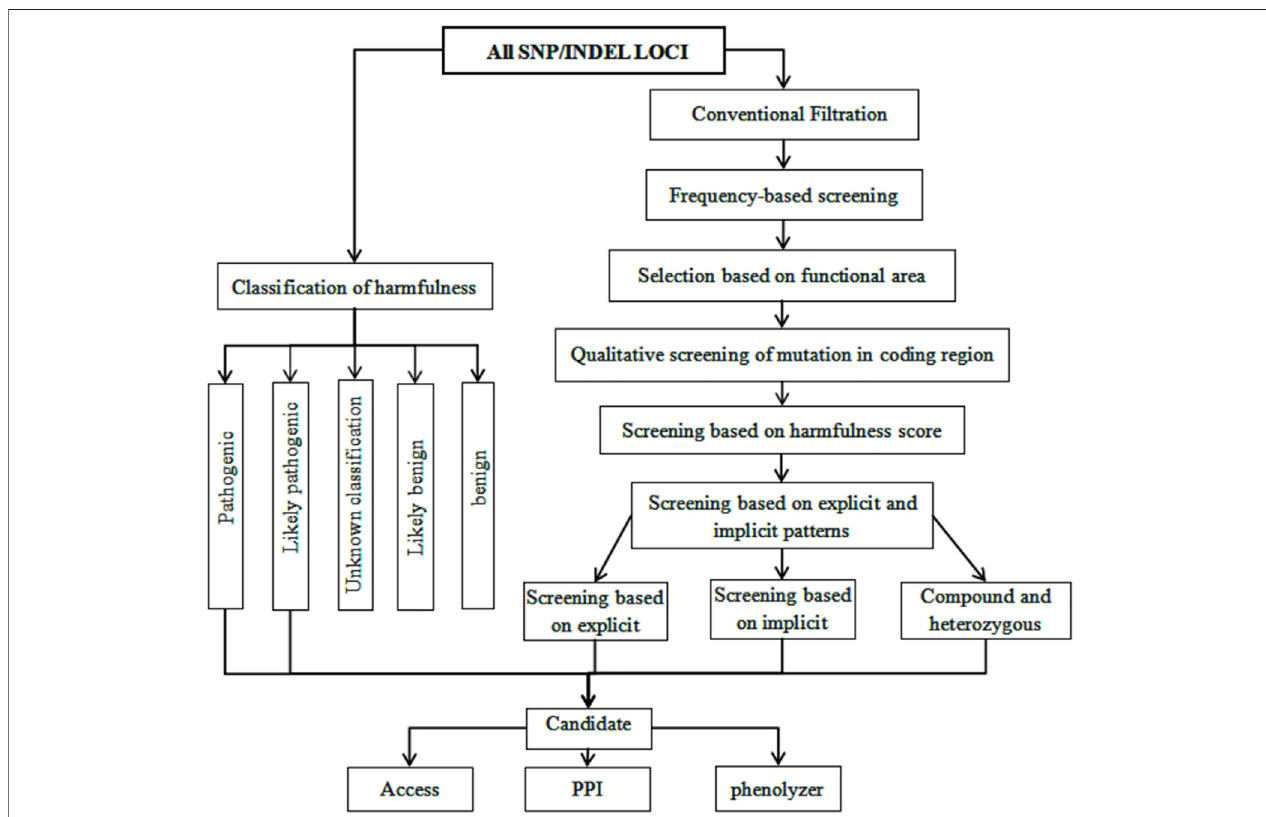
FIGURE 2 | Analysis Flow Chart 2. Advanced analysis pipeline: Screening based on mutation sites and their harmfulness; Screening based on sample recessive patterns;Screeningbasedoncandidategenesandrelationshipwithdiseasephenotypes;PathwayenrichmentofcandidategenesthroughGOandKEGGanalysis(also using DisGeNet and Phenolyzer to analyze gene-disease phenotype